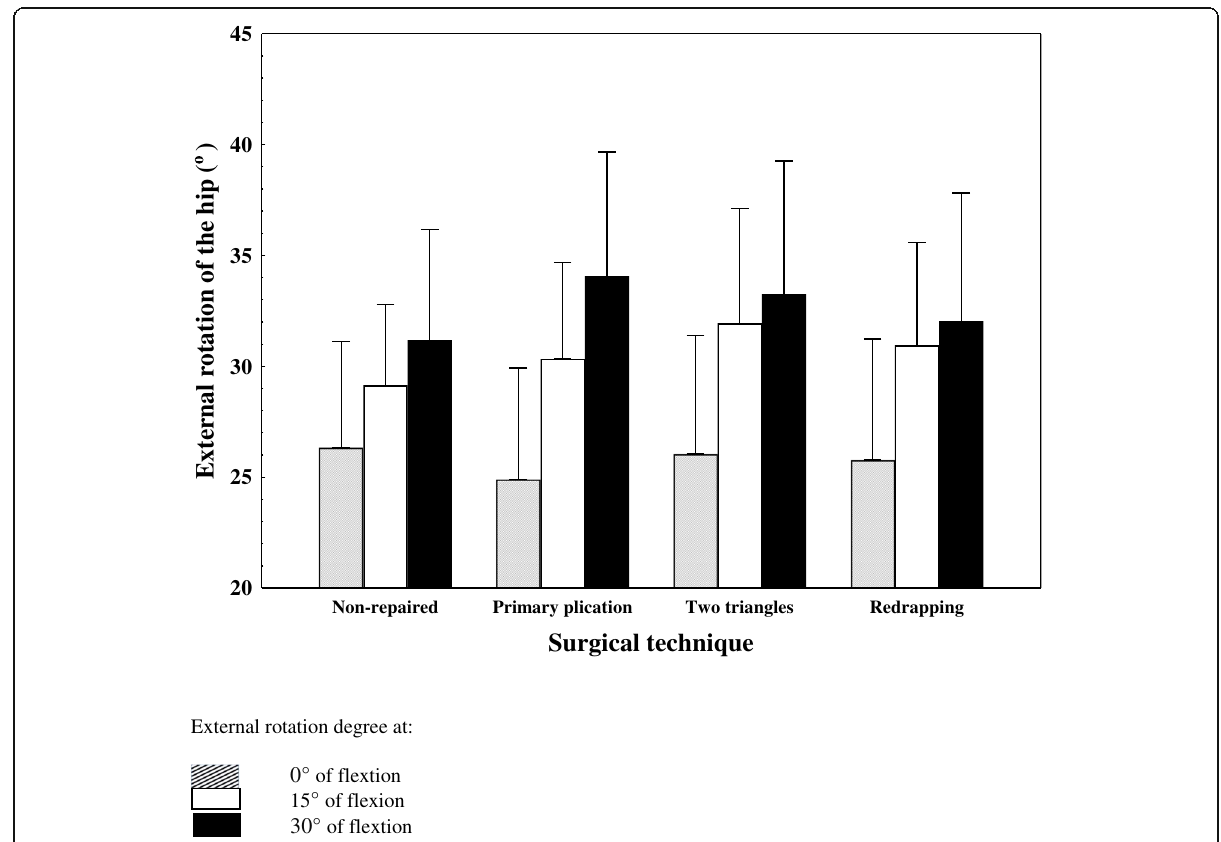
Fig. 5 Mean external rotation of the hip for each surgical technique. Vertical bars denote 95% confidence